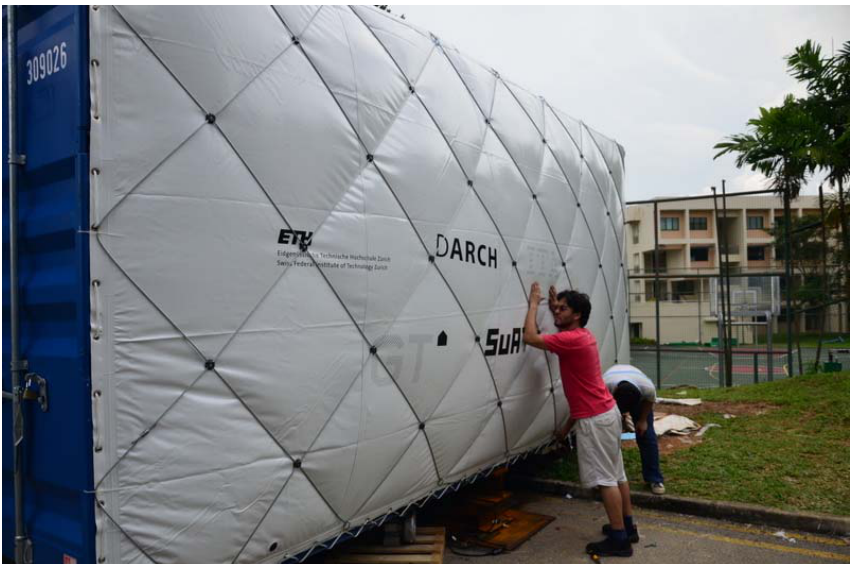
Figure 3. Picture of the BubbleZERO in